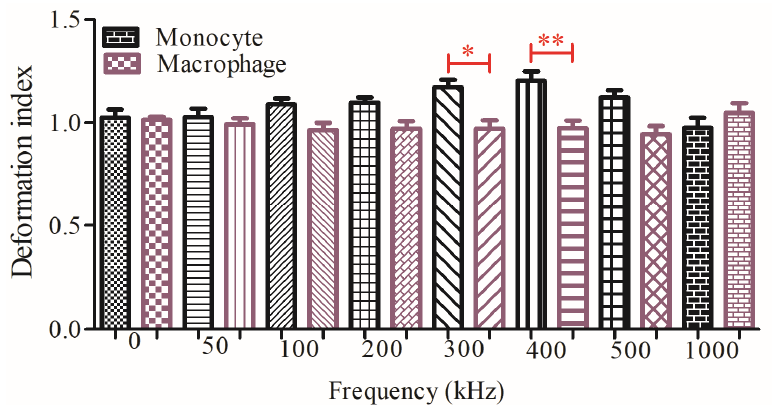
Figure 5. Comparison of the dielectrophoretic deformation indexes for the monocytes and macrophages without outliers. Measurements are the dielectrophoretic deformation index with mean and standard error for 45 monocyte and 45 macrophages cells. Tukey’s multiple comparison test is applied. * and ** indicate that data are significantly different with p < 0.5 and p < 0.05, respectively.